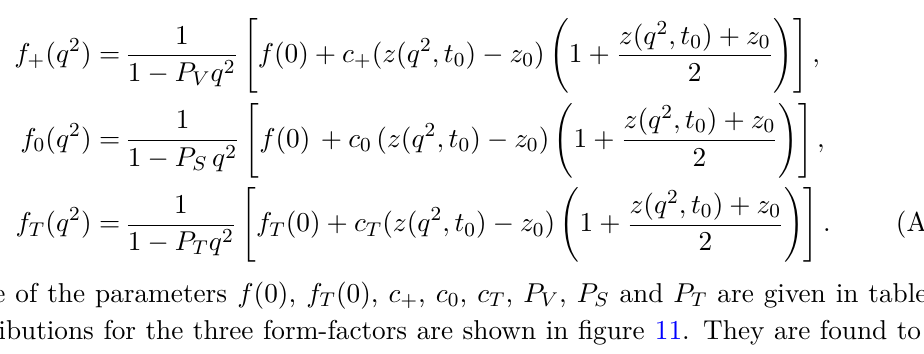
Figure 11 . Form factors for D → π , f + ( q 2 ) and f 0 ( q 2 ) from ref. [17] and f T ( q 2 ) from ref. [18]. for t = ( m + m ) 2 and t + π D